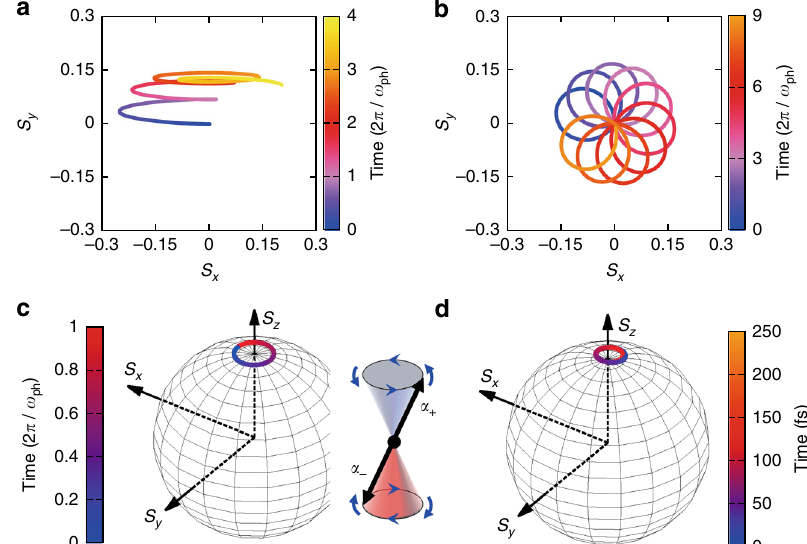
Fig. 3 Time evolution of the spin driven by the E ″ mode. a , b Model Hamiltonian calculation of the spin trajectory starting at t = 0 with the spin-down state shown in Fig. 1a with a a linearly polarized and b a circularly polarized in-plane magnetic fi eld. c , d The Floquet eigenstate on the Bloch sphere for c the model Hamiltonian with the circularly polarized in-plane magnetic fi eld and d the full TDDFT solution with the circularly polarized E ″ phonon. The inset of c depicts schematically the two Floquet eigenstates, α and α described in the main text. In a – c the time scale is presented in units of the E ″ phonon period, þ (cid:2) i.e., T = 2 π / ω ph = 122